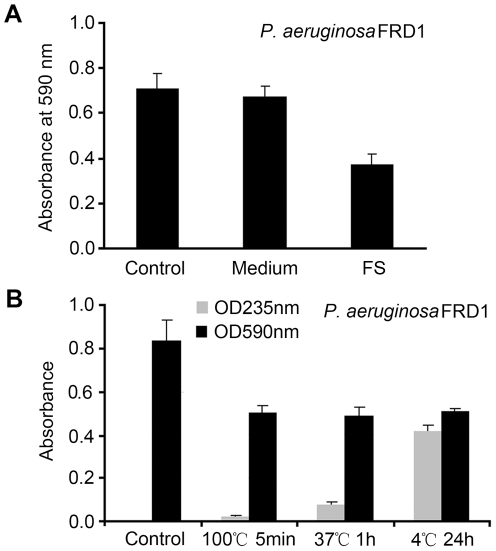
Effect of Vibrio sp. QY101 supernatant on biofilm formation of P. aeruginosa FRD1.
Vibrio sp. QY101 was grown in AM at 25°C for 4 days. Its supernatant was taken to examine the effect on bacterial biofilm formation. P. aeruginosa FRD1 biofilm formed in micro-tubes at 37°C for 24 h. Attached biofilm biomass was determined by measuring crystal violet retained at OD590 nm. Results are the average of six replicates ± SD at least three independent experiments. (A) 1/10 (v/v) supernatant was added in the cultures. (P<0.01). Control: sterile water; Medium: alginate medium; FS: fermentation supernatant. (B) The supernatant was treated to make the alginate lyase inactive before being added in the cultures. Alginate lyase activity was measured by an increase in absorbance at 235 nm of the reaction products.